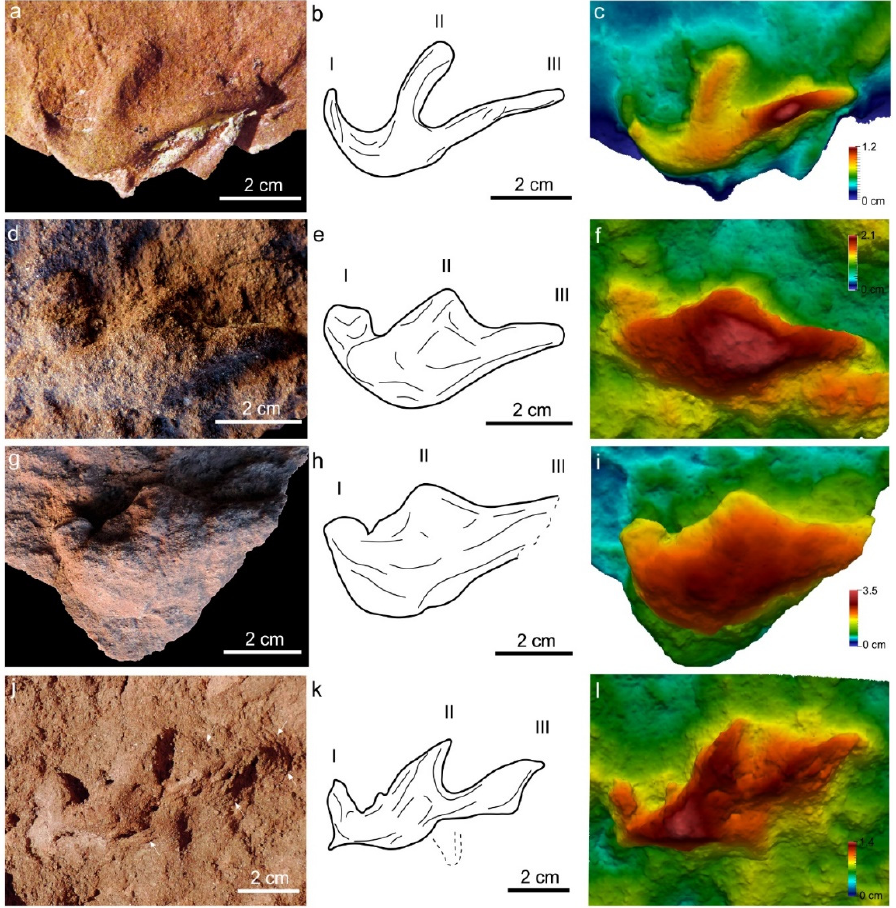
Figure 4. Details of the four pterosaur manus impressions: ( a ) photography of M1 impression; ( b ) interpretative drawing of M1; ( c ) false-color depth image of M1; ( d ) photograph of M2; ( e ) interpretative scheme of M2; ( f ) false-color depth image of M2; ( g ) photograph of M3; ( h ) interpretative scheme of M3; ( i ) false-color depth image of M3; ( j ) photograph of M4; ( k ) interpretative scheme of M4; ( l ) false-color depth image of M4. References: white arrows indicate striae.